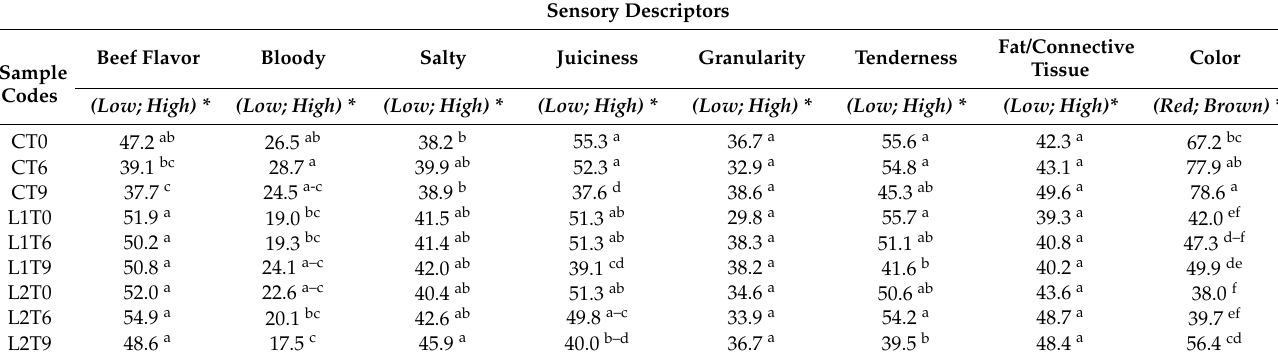
Table 7. Mean values (five replicates) of the intensity of the attributes evaluated by QDA ® of burger samples (C, Control (minced beef meat + maltodextrine + starter cultures); L1, minced beef meat + starter cultures + 87.5 mg phenols/kg of meat; L2, minced beef meat + starter cultures + 175 phenols/kg of meat) at all of the storage times (T0, T6, and T9), expressed on a scale from 0 to 100 (0 indicates the absence of perception of the attribute, while 100 corresponds to the maximum perception of the attribute) * extremes of the